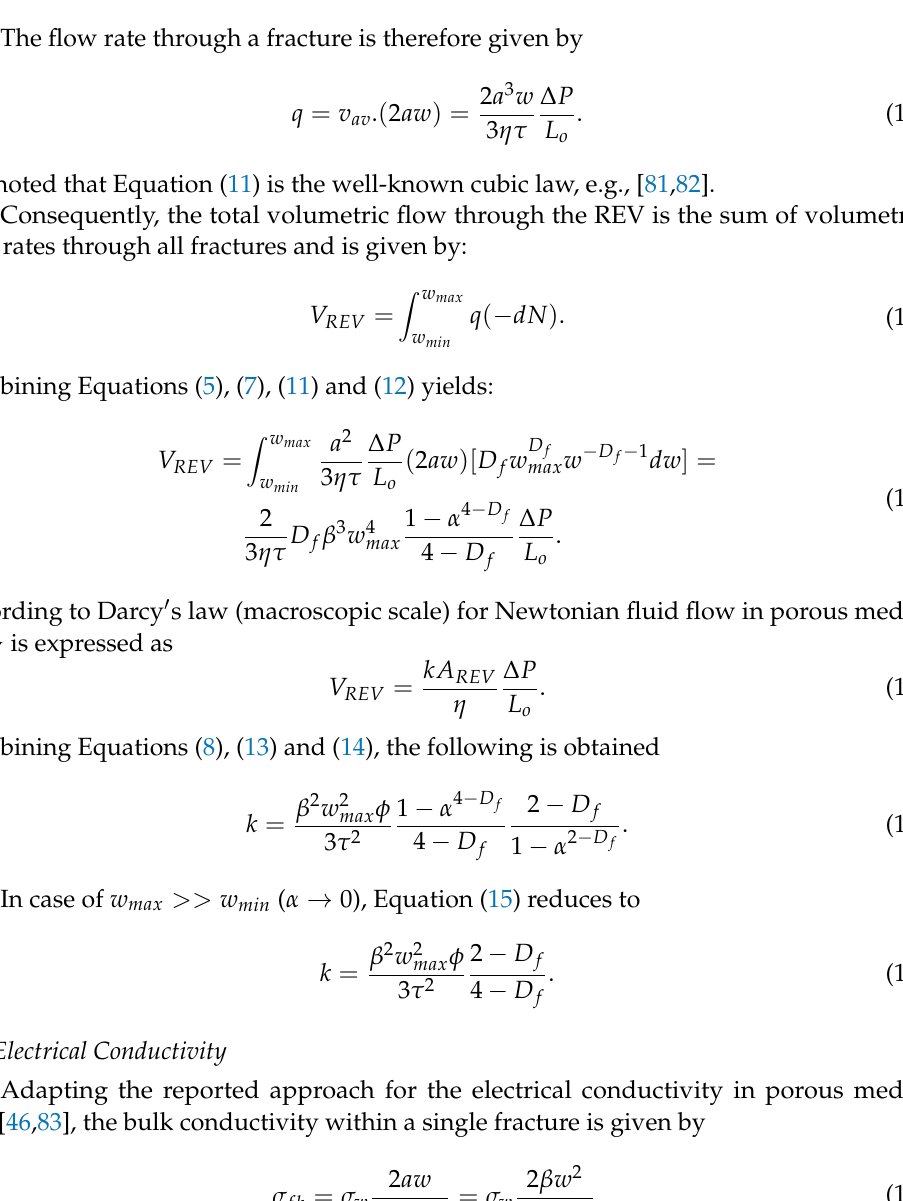
Figure 2. Fluid flow in a fracture and the coordinate along the aperture ( a << w << L o